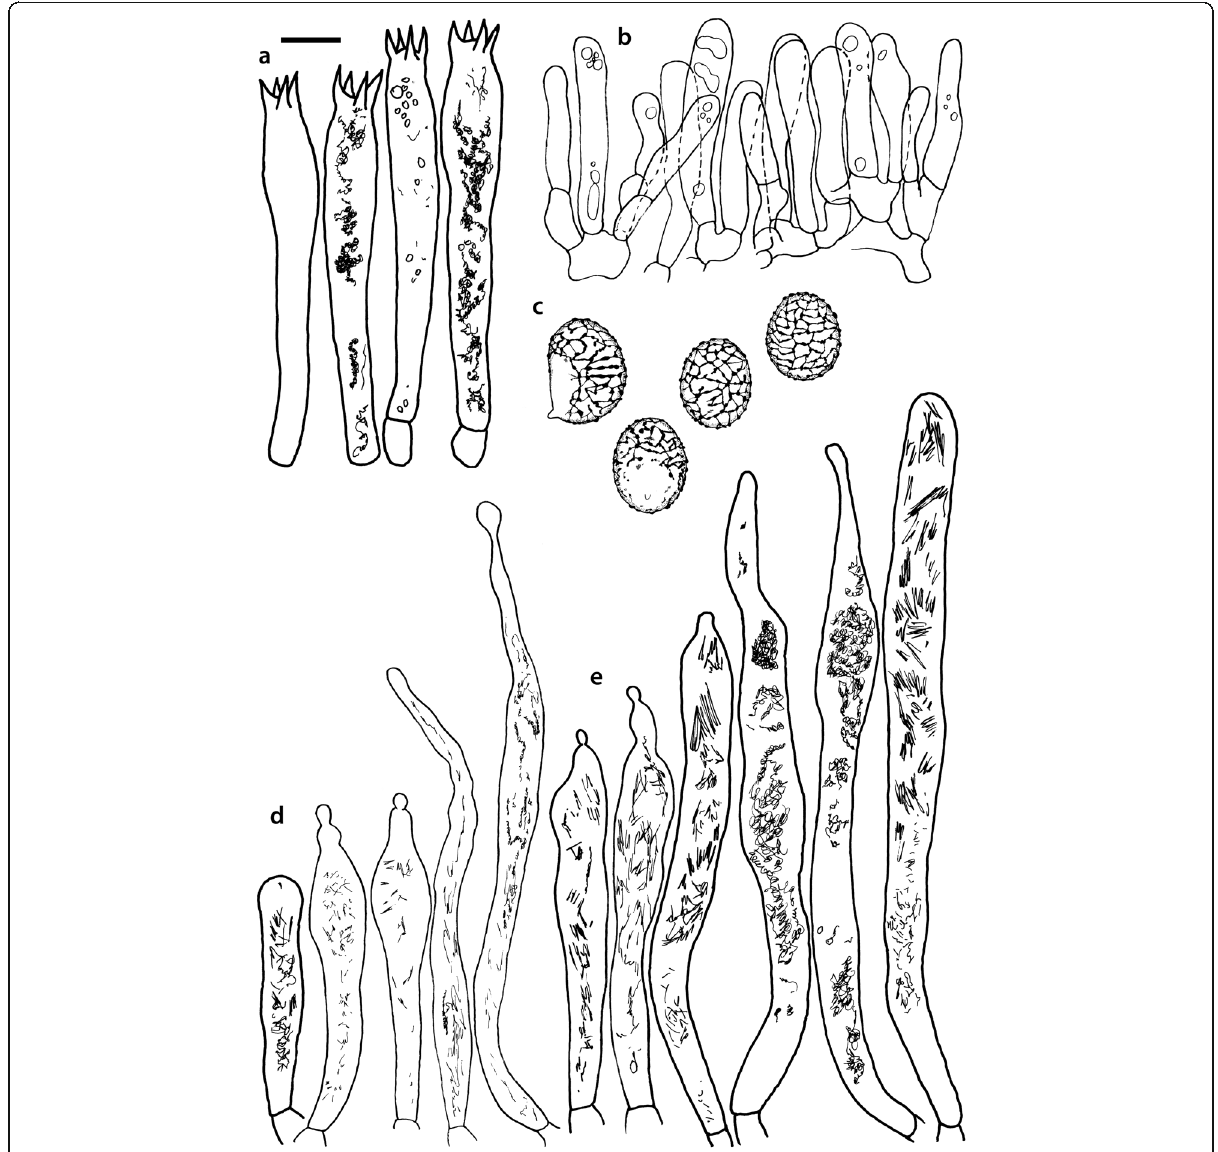
Fig. 8 Russula ambusta (SAV F-3358, FH 2008 ST01), hymenium. a Basidia. b Marginal cells. c Basidiospores. d Cystidia near lamellae edges. e Cystidia on lamellae sides. Bar = 10 μ m, except for c 5 μ